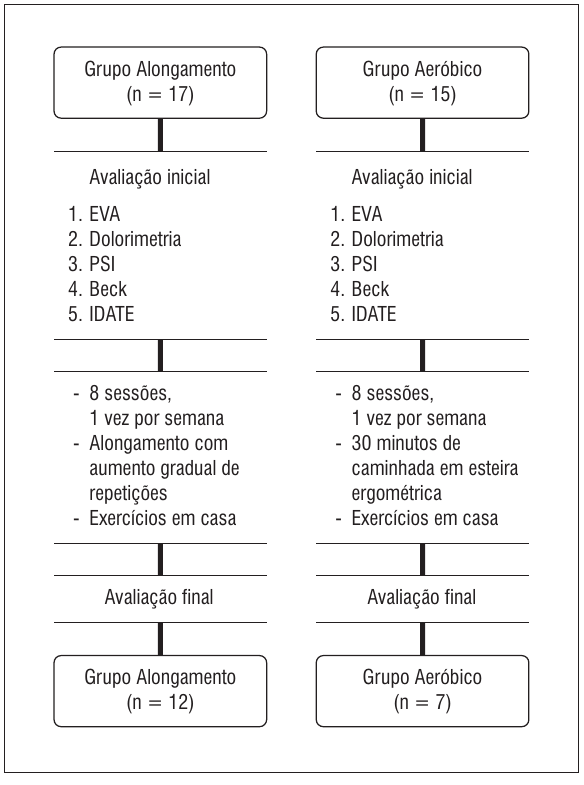
Figura 1 - Organograma dos protocolos de tratamento colos de tratamento utilizados no